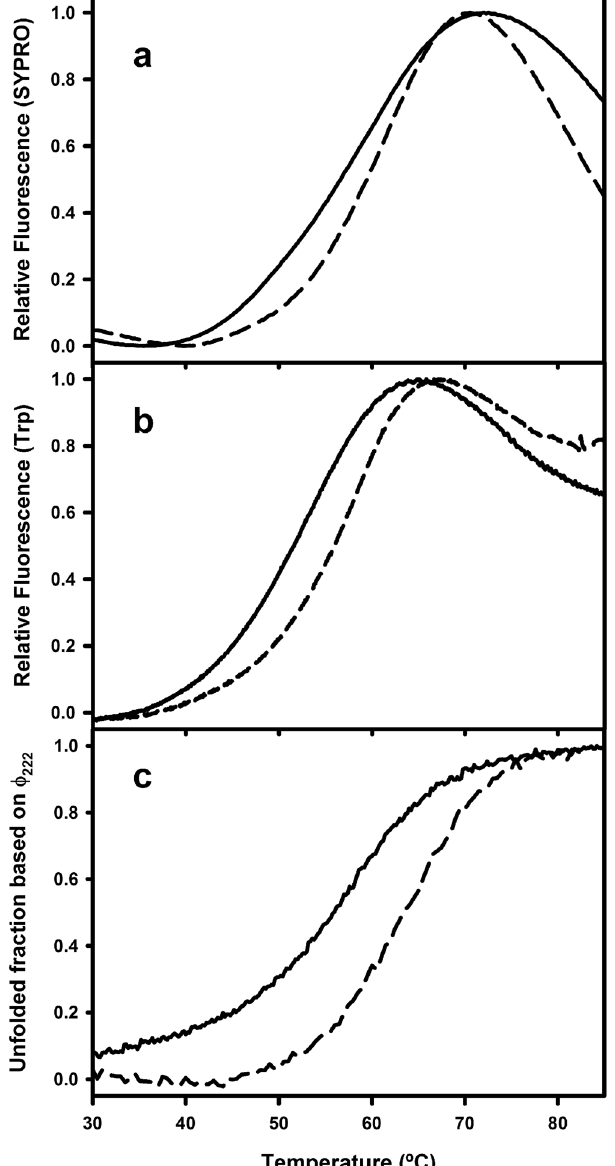
Figure 1. Thermal stability of full length nucleophosmin (NPM) and isolated C-terminal domain. Thermal denaturation profiles monitored by DSF ( a ), tryptophan emission fluorescence ( b ) and circular dichroism (ellipticity at 222 nm) ( c ). Solid and dashed lines correspond to the isolated C-terminal domain and to full length NPM, respectively. The protein concentrations were 10 µ M for full-length NPM and 50 µ M for the C-terminal domain, prepared in 50 mM sodium phosphate buffer, pH